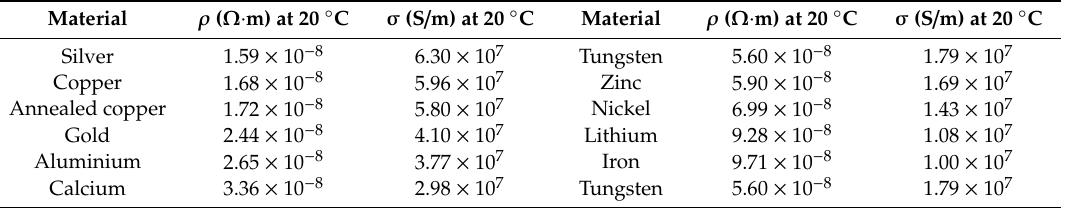
Table 6. Conductor materials resistivity and conductive